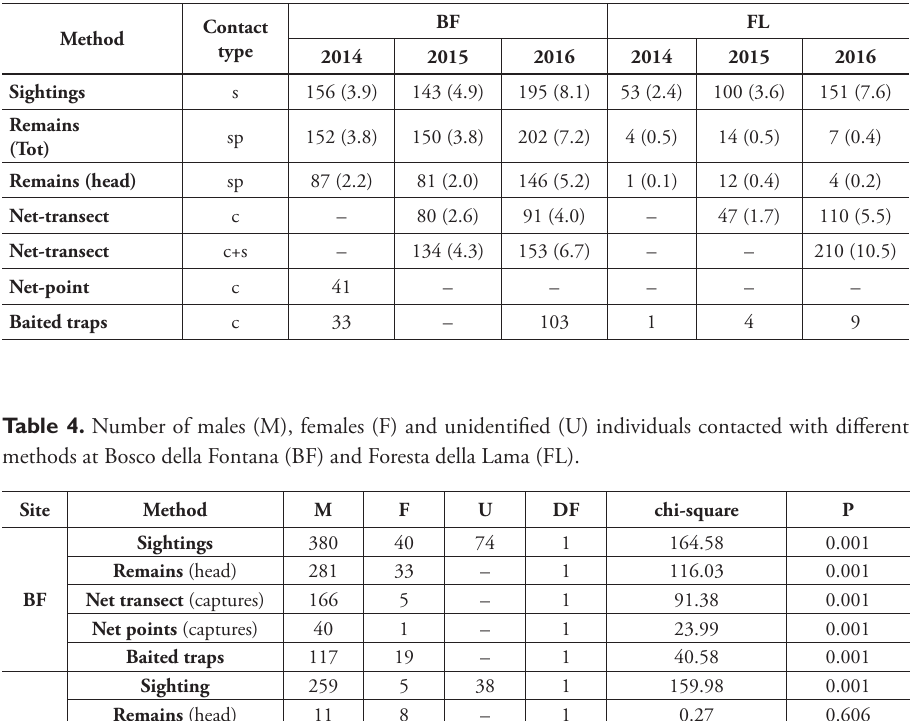
Table 3. Summary of number and mean values (in brackets) of contacts (c = captures; s = sightings; sp = specimens; Tot = total counting; head = head counting) for each method, in the two study areas Bosco della Fontana (BF) and Foresta della Lama (FL) during the three years of monitoring.